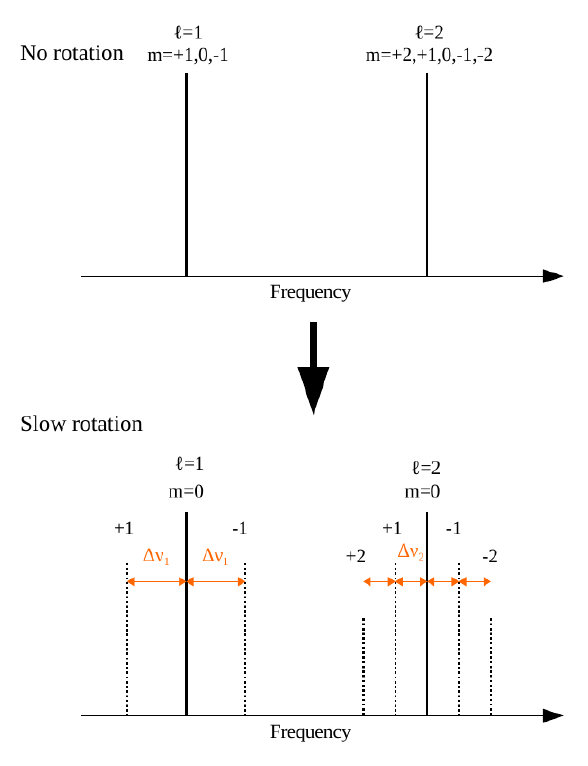
Figure 1. Schematic representation of the effect of slow rotation on oscillation modes. Without rotation, a mode is (2 ℓ + 1)-fold de- generate in m , all components having the same frequency. These components are separated when rotation is present, forming nearly symmetric triplets for ℓ = 1, quintuplets for ℓ = 2, and so-on. The frequency spacing between the components of a multiplet is easily measured and offers a direct way to estimate the average rotation rate of the